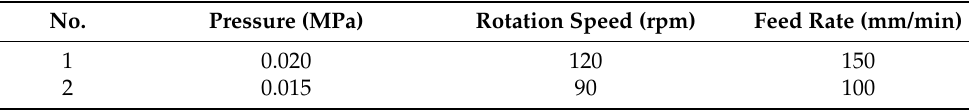
Table 5. Parameters of smoothing